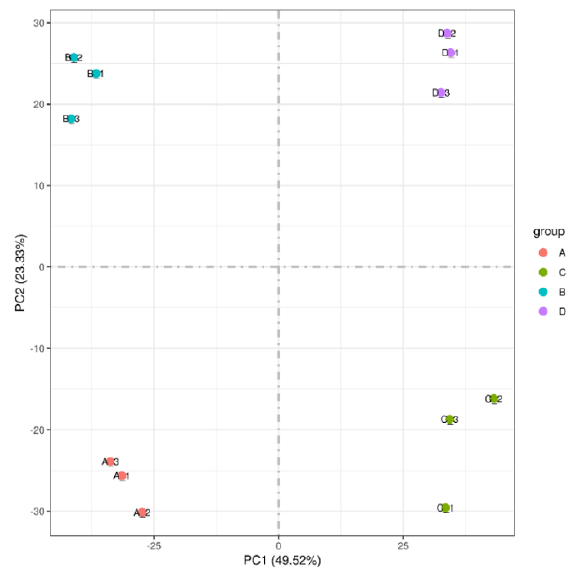
Figure 8. Principal component analysis between transcriptome samples. A , RR without inoculation; B , RS without inoculation; C , RR inoculated for 5 days; D , RS inoculated for 5 days.